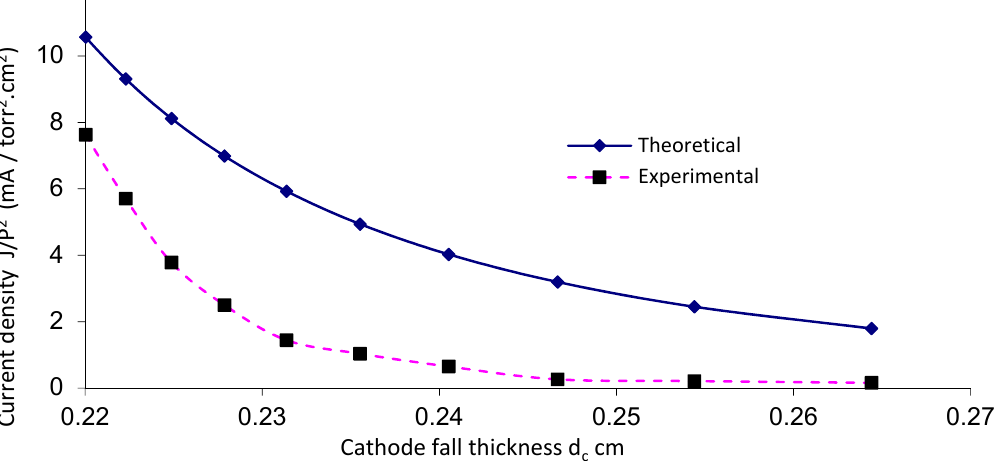
Figure 9. Current density as a function of the cathode fall thickness for OMTSE with applied pressure of 1 mTorr.